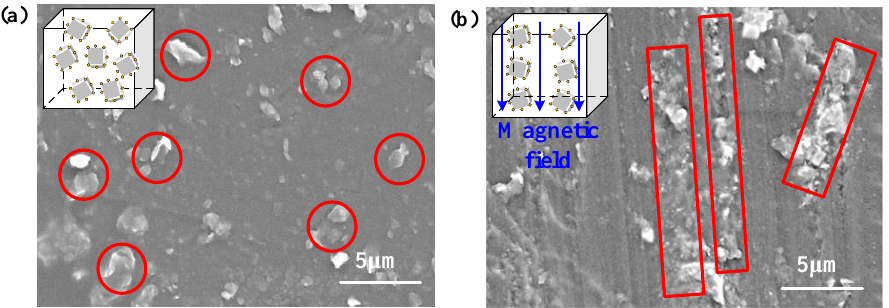
Figure 7. SEM images of randomly oriented SiC/EP composites and orderly oriented SiC/EP composites. ( a ) Randomly oriented M-SiC/EP-N composites; ( b ) orderly oriented M-SiC/EP-C composites.